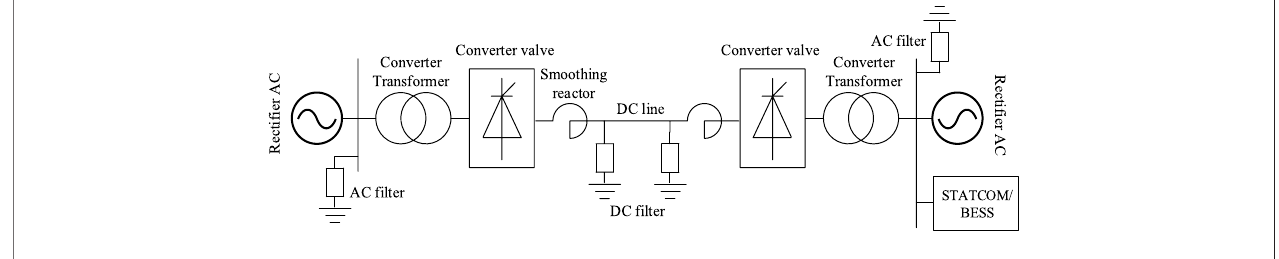
FIGURE 8 | LCC-HVDC simulation system.